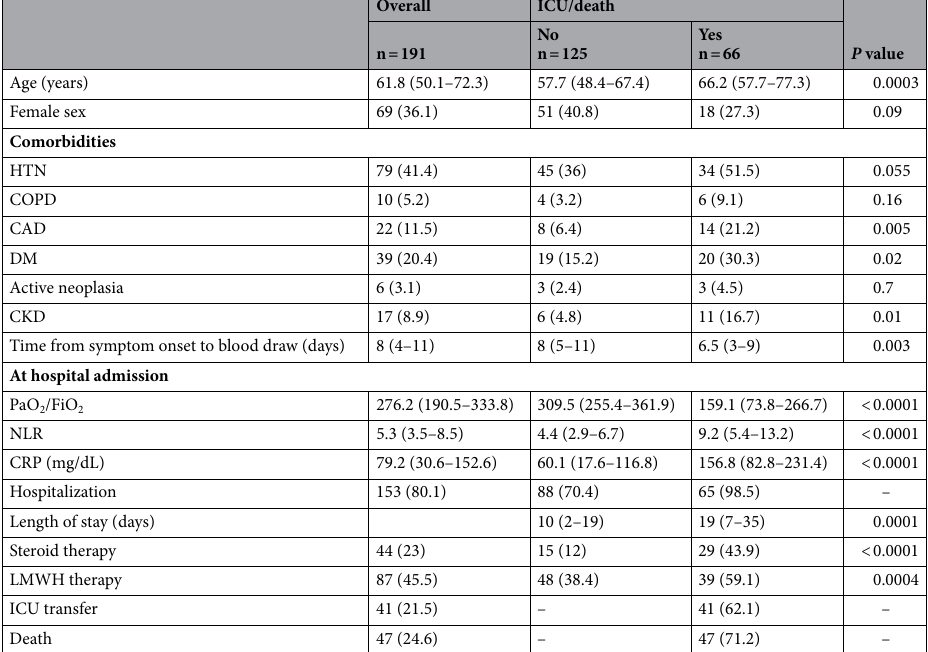
Table 1. Characteristics of COVID-19 patients. Categorical variables were expressed as count (percentage), while continuous variables as median (interquartile range). ICU Intensive care unit, HTN Arterial hypertension; COPD Chronic obstructive pulmonary disease, CAD Coronary artery disease, DM Diabetes mellitus, CKD Chronic kidney disease; PaO 2 /FiO 2 Ratio of arterial oxygen partial pressure to fractional inspired oxygen, NLR Neutrophil to lymphocyte ratio, CRP C-reactive protein, LMWH Low-molecular weight heparin.